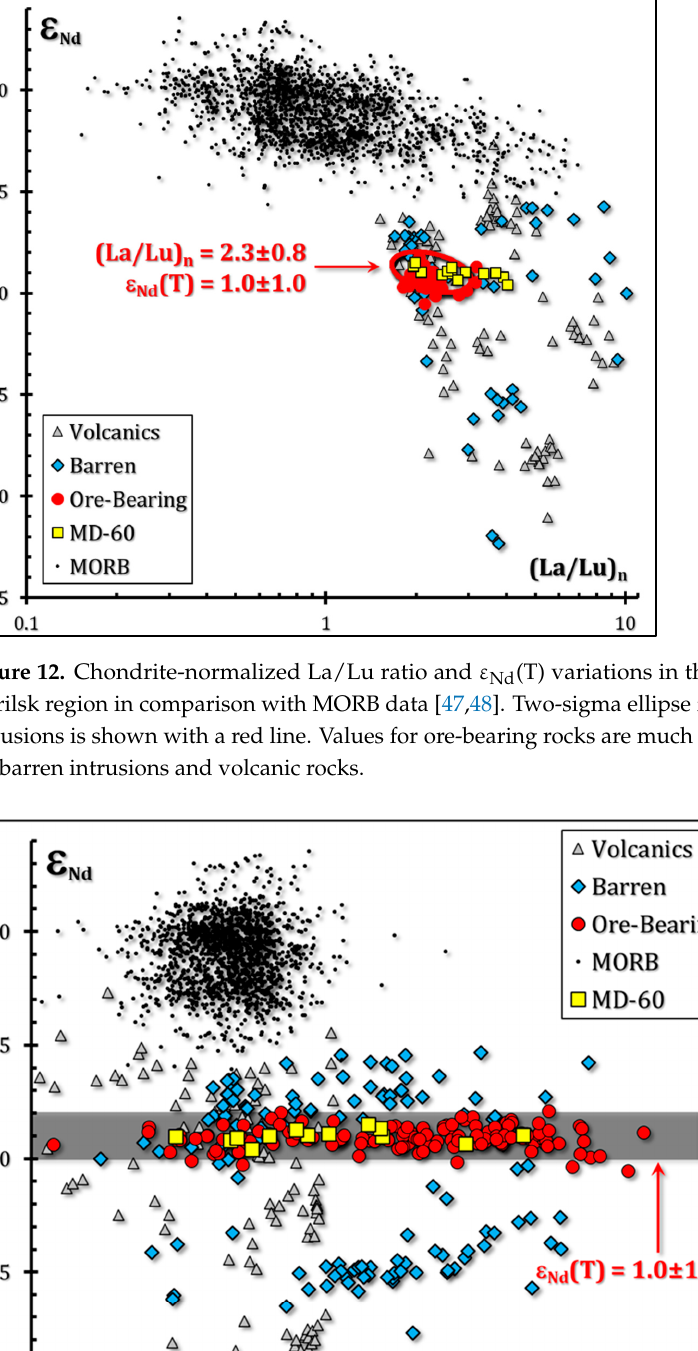
former form a very compact cluster, whereas the latter show a wide range of these parameters similar to volcanics. The ellipse shown in Figure 12 can be used as the most reliable signature of potentially economic Cu-Ni-PGE deposits in this part of the Siberian province. The gabbro-dolerite intrusion at the Mikchangda area discovered by the MD-60 borehole does not differ in all geochemical parameters from the rocks of ore-bearing massifs (Figures 8–14). They have the same compact isotopic composition of Nd, only slightly wider variations of the La/Lu ratio and the Sr isotopic composition (Figure 14). These data indicate that the rocks uncovered by the MD-60 borehole may be of practical interest to mining companies. Statistical analysis confirms obvious similarity of Nd